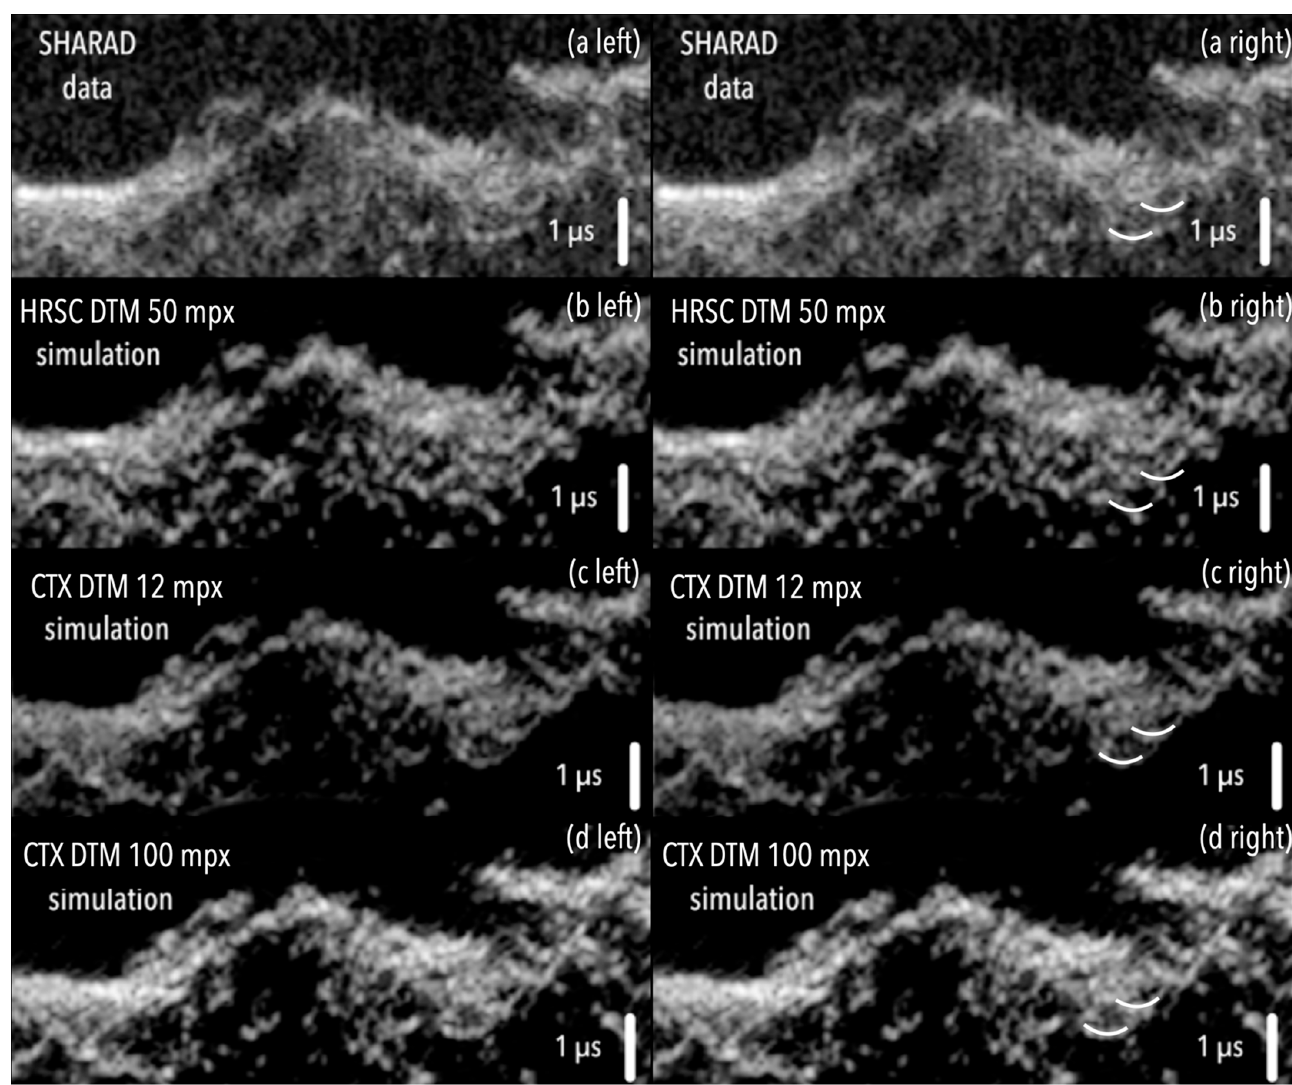
Figure 9. Comparison between a 40 km portion of the SHARAD dataset n°5128501 and the simulation of it using different DTMs. The results using the downsampled CTX DTM (d) at 100 m per pixel represents the echoes more accurately than the simulation using the HRSC DTM at 50 m per pixel (finer details visible and lower level of artifacts). Parabolas on the right images highlight the echoes that are most significatively improved by the CTX simulation, as the left images are there to visualize the echoes without figures on top.